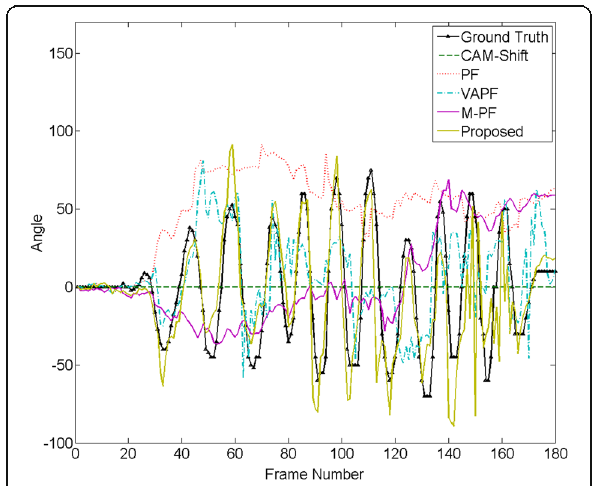
Fig. 24 Estimated object rotation angle of “ book ” compared with ground truth with the particle number N =